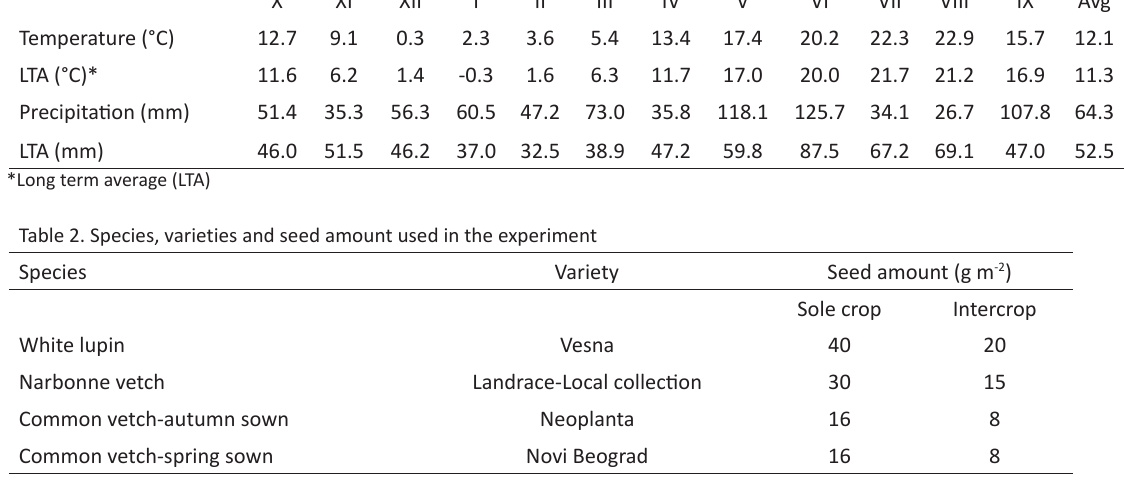
Table 1. Temperatures and precipitations for hydrological year 2012/2013 at Rimski Šančevi Parameter